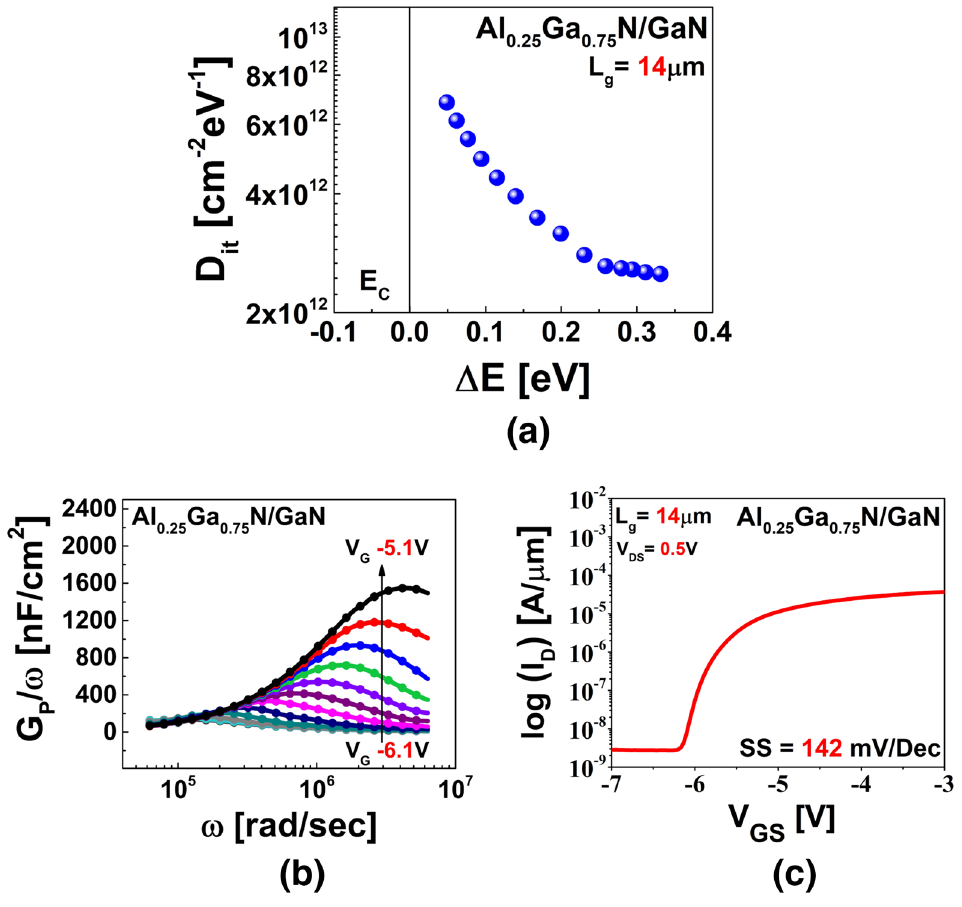
Figure 3. ( a ) Distribution of interface traps as a function of band energy state. ( b ) Equivalent parallel conductance ( G P /ω ) with respect to frequency at different gate bias points. ( c ) Basic transfer curve (log( I D )– V GS ) showing SS of